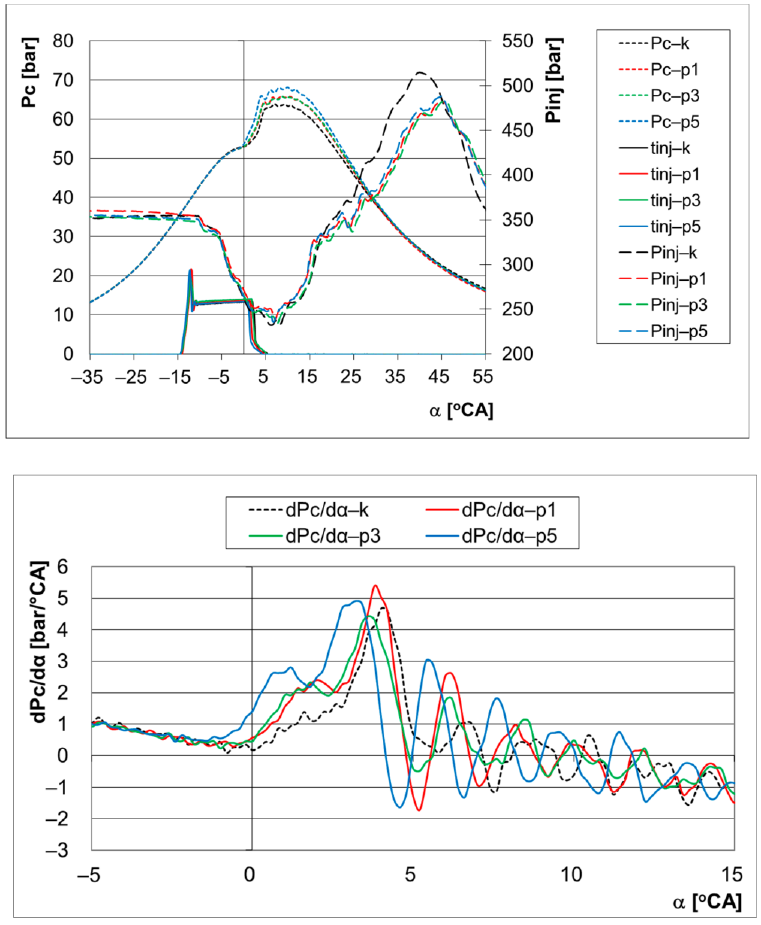
Figure 7. The waveform of the time signal t inj that controlled the injector, pressure P inj in the accumulator, pressure P c in the cylinder, and the rate of pressure rise dP c / d α under engine load ET = 15 [ N · m ]